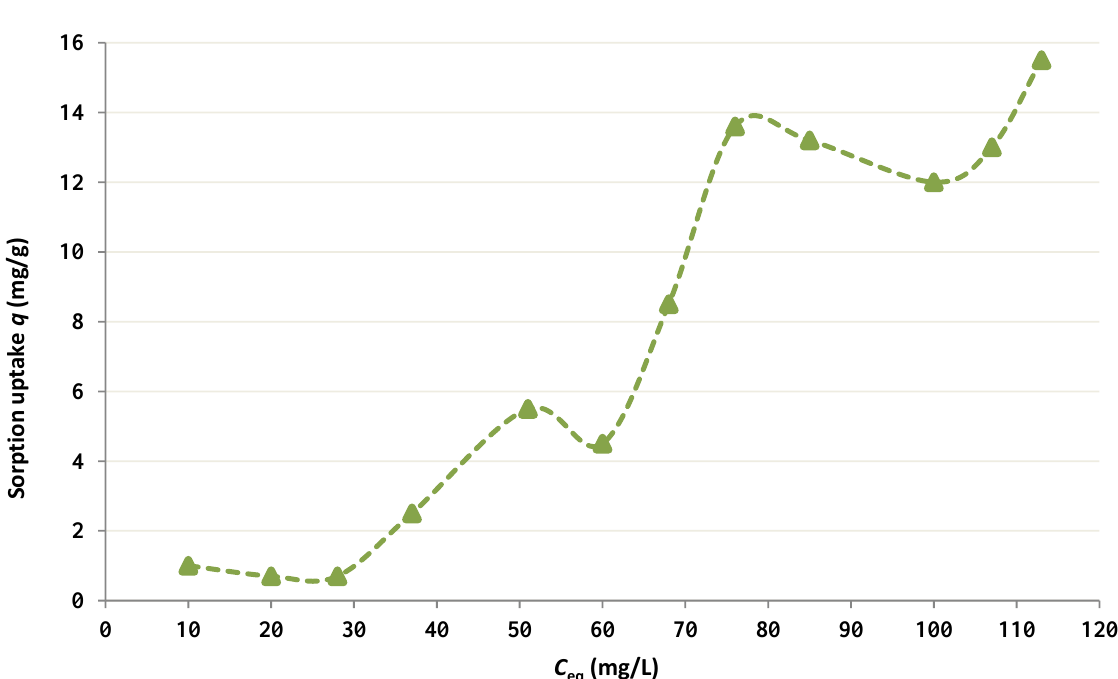
Figure 1. Kinetics of Co uptake by chitin at pH = 3 and pH = 4.